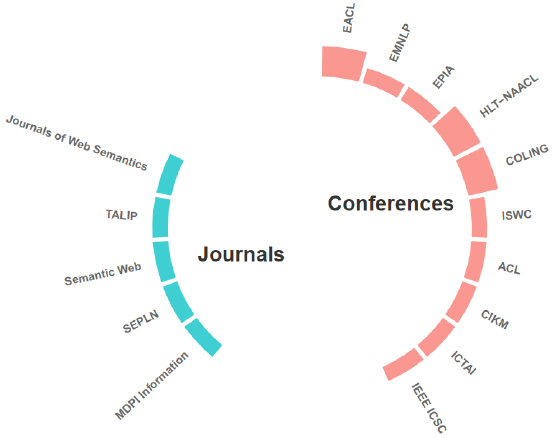
Figure 4. Distribution of the selected papers on Journals and Conferences. (Authors’ own).